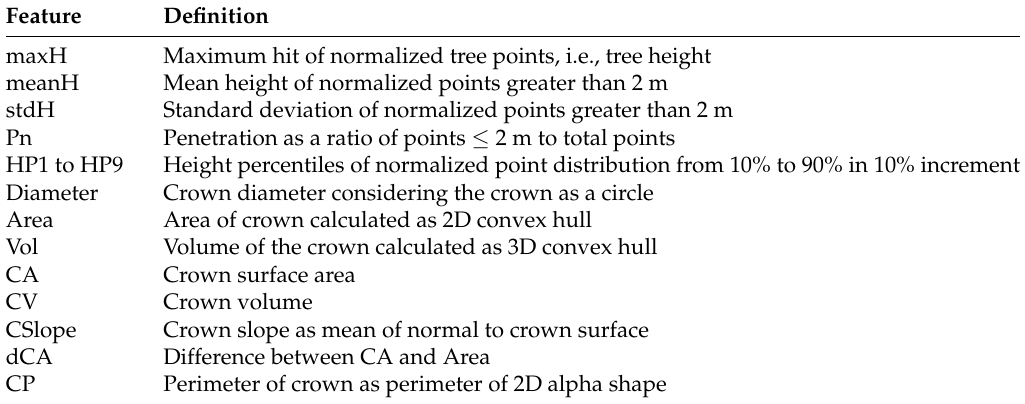
Table 5. Tree-level features derived from the airborne laser scanning (ALS) data. These features were used to predict the diameter at breast height (DBH) and stem volume using a random forest model. In the table, normalized points refer to points, for which the ground level has been subtracted from the z